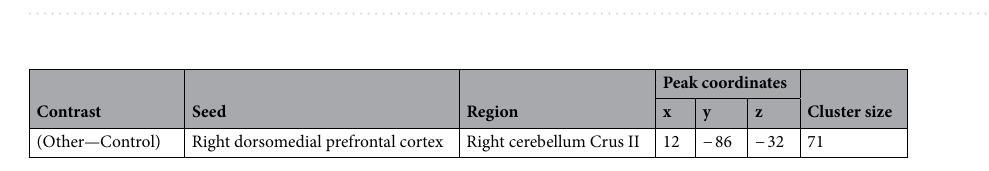
Figure 3. Between-group differences in activation levels during the (Other—Control) contrast. Activation maps of the clusters of between-group differences during the (Other—Control) contrast isolating other- related processing. Error bars correspond to the standard error. PLE-0 = control trajectory; PLE-1 = decreasing trajectory; PLE-2 = increasing trajectory. **p < 0.001.